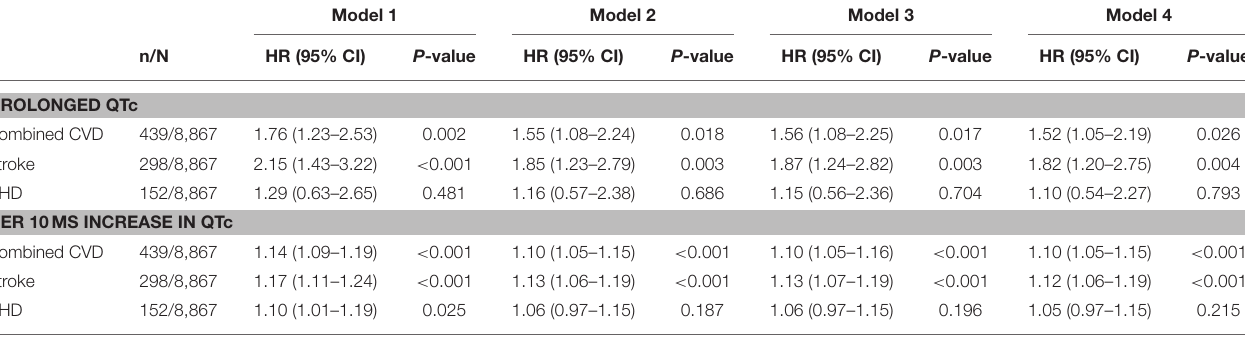
Model 1: adjusted for age, sex and ethnicity. Model 2: adjusted for model 1 + current smoking, family history of coronary heart disease, body mass index, systolic blood pressure, antihypertensive medications, fasting plasma glucose, total cholesterol, triglyceride, high-density lipoprotein cholesterol, low-density lipoprotein cholesterol and estimated glomerular filtration rate. Model 3: adjusted for model 2 + QT prolonging medications, statin use, warfarin use and aspirin use. Model 4: adjusted for model 3 + atrial fibrillation and left ventricular hypertrophy. ProlongedQTcdefinedas460msorlongerinfemalesand450msorlongerinmalesusingFraminghamformula.nmeansthenumberofevents;Nmeansthenumberofstudypopulation.